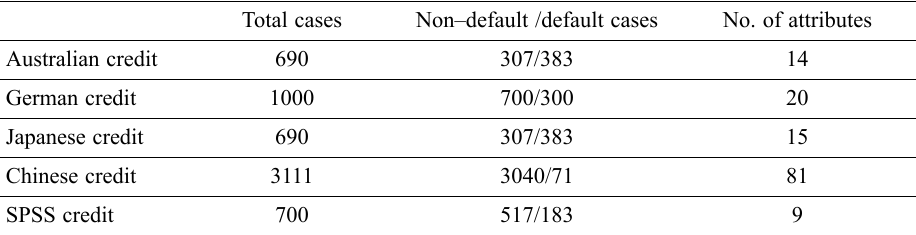
Table 1. Description of databases used in the experiment